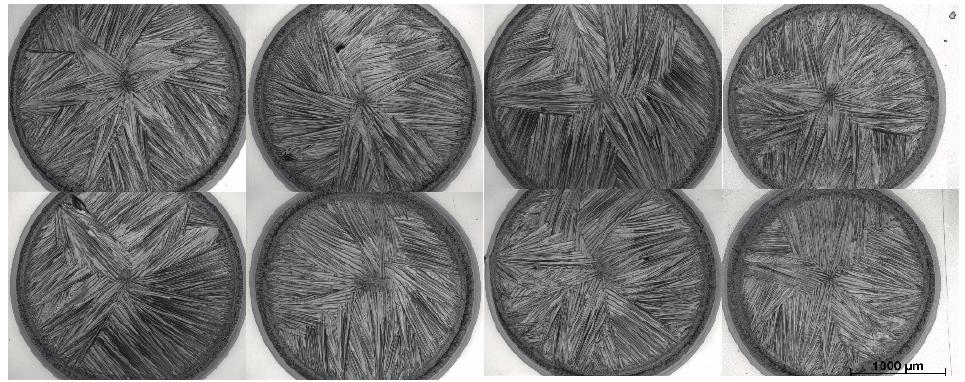
Figure 9. Microscope images of the drops from experimental part IV indicating a high degree of reproducibility in the different dispensed